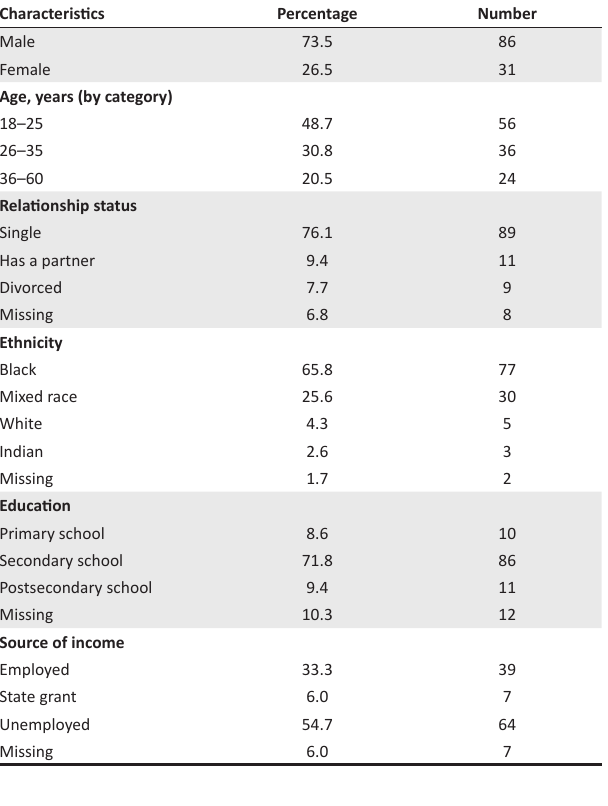
TABLE 1: Demographics and clinical characteristics of patients with first-episode psychosis ( N = 117).